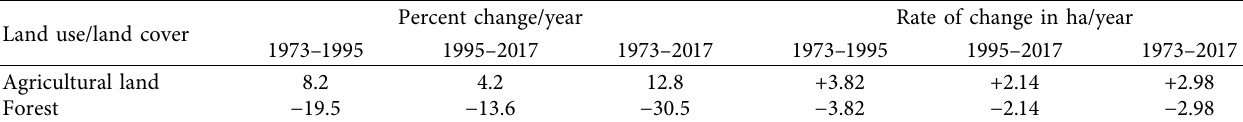
Figure 4: Land use/land cover changes of Shenkolla in the years (a) 1973, (b) 1995, and (c) 2017. Table 5: Percent and rate of land use changes in the Shenkolla watershed from 1973 to